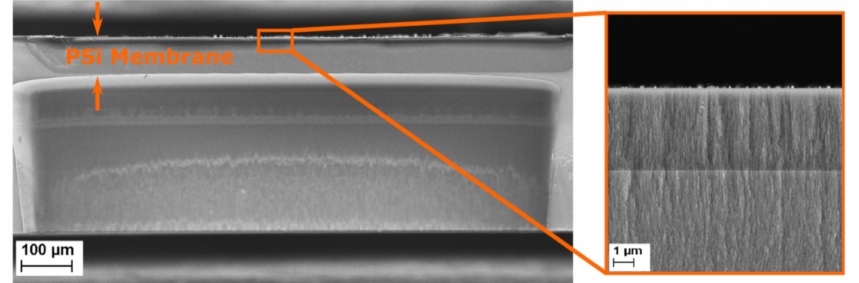
Figure 4. Scanning electron microscopy (SEM) cross-section image of a multilayered porous silicon membrane. The inset shows a close-up of the top of the porous membrane, in which the sensing and the contrast layers can be